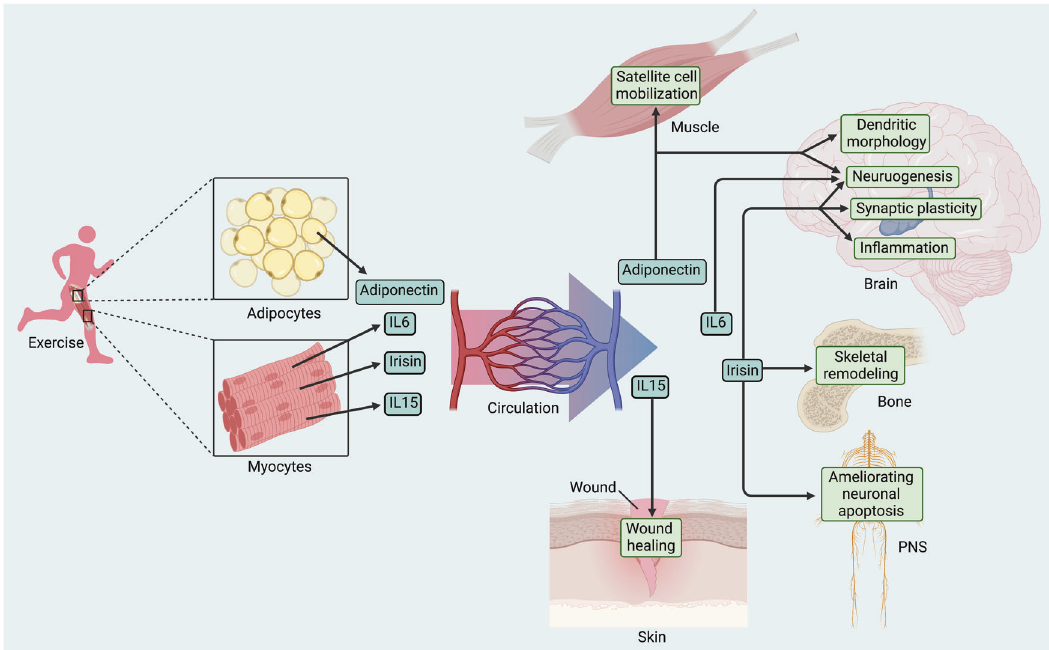
Fig. 8 Natural molecular mediators. A set of exerkines are considered as candidate exercise mimetics, including irisin, adiponectin and interleukin, which can be used as gene therapy. These emerging target molecules provide new insights into the mechanisms of injured tissue regeneration and facilitate the ef fi ciency of clinical translation. Created with